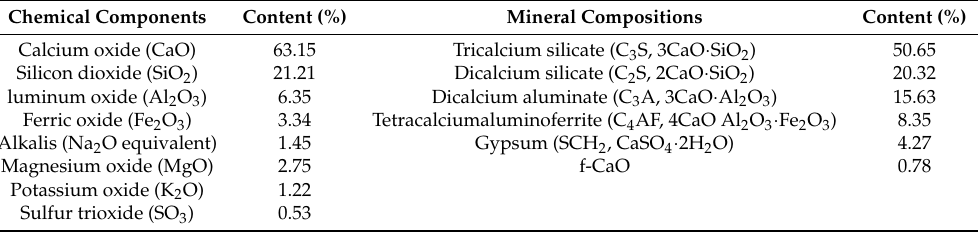
Table 1. Chemical and mineral compositions of the Portland cement